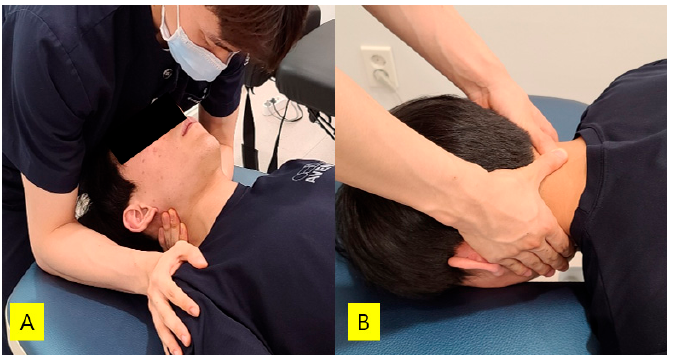
Figure 1. Two type of cervical joint mobilization techniques: ( A ) lateral glide mobilization; ( B ) pos- terior–anterior